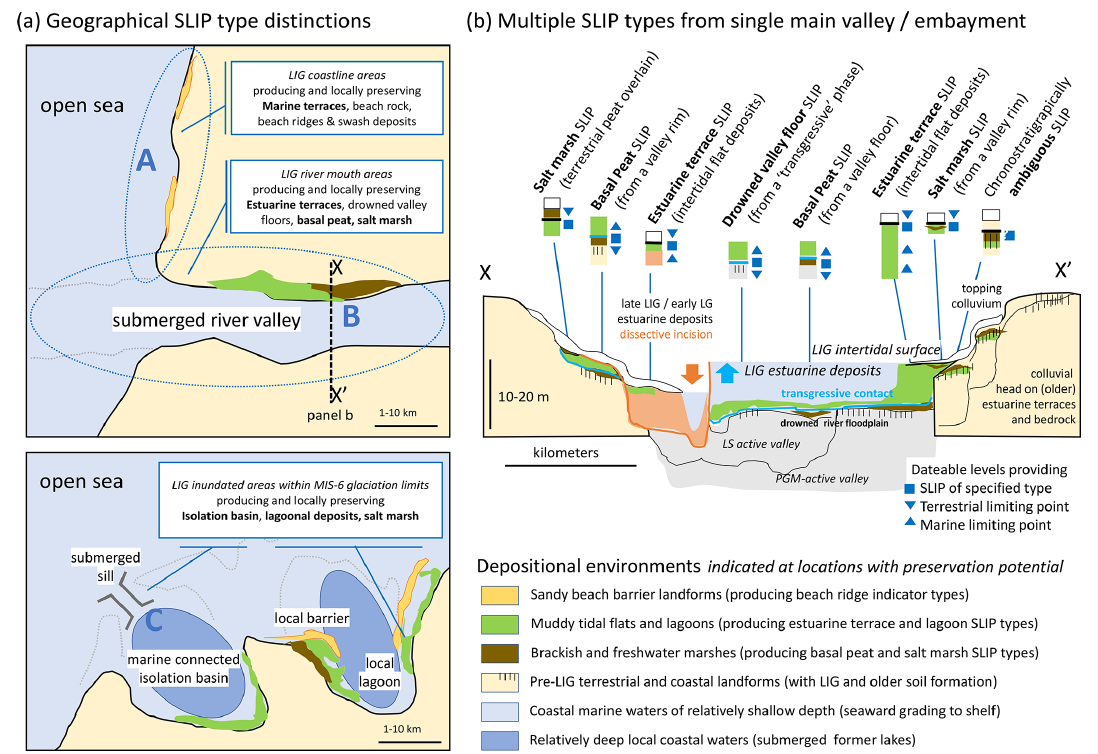
Figure 2. Schematic map (a) and section (b) illustrating the geographical and sedimentary distinctions between the various SLIP types used for NW Europe in the WALIS database. In panel (a) three main groups of SLIPs are distinguished: A – coastline areas facing open sea, B – estuaries filling drowned river valleys, and C – glacially inherited marine-connected isolation basins and embayments. In panel (b) multiple SLIP types as well as terrestrial and marine limiting data points are summarised from local outcrops and boreholes. This includes SLIPs which record RSL rise, SLIPs which record stable sea level, and SLIPs which record RSL fall causing dissection and incision (orange arrow) within the estuarine cross-section. The symbology introduced for SLIP, terrestrial limiting and marine limiting points matches those in Fig. 1 and Figs. 4 and 5. Drowning sequences (e.g. submerged valley floors or basal peats, spanning a local or regional transgressive contact, common from early to middle interglacial phases in NW Europe) below the potential SLIP position often record a further terrestrial limiting data point. In contrast, estuarine terrace SLIPs typically have marine limiting indicators from facies underlying the SLIP and are common from middle–late and post-interglacial phases (Table